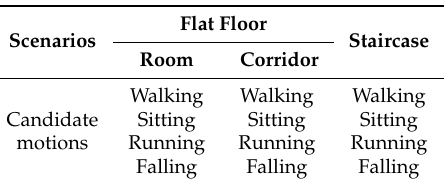
Table 3. Candidate motions in the two environments.